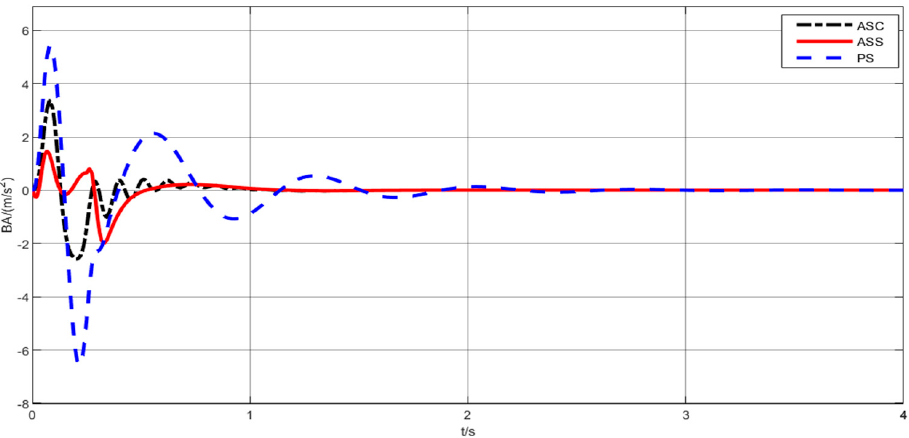
Figure 10. Bump body acceleration responses of different suspensions.